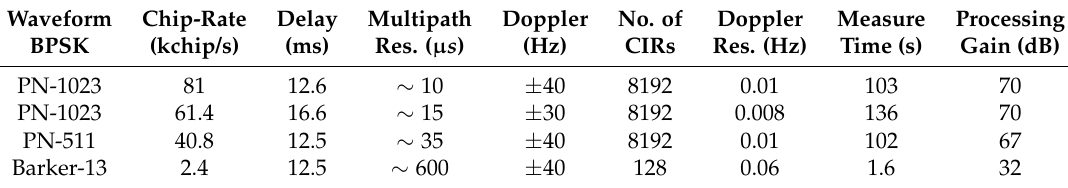
Table 2. Characteristics of different WHISPER sounder